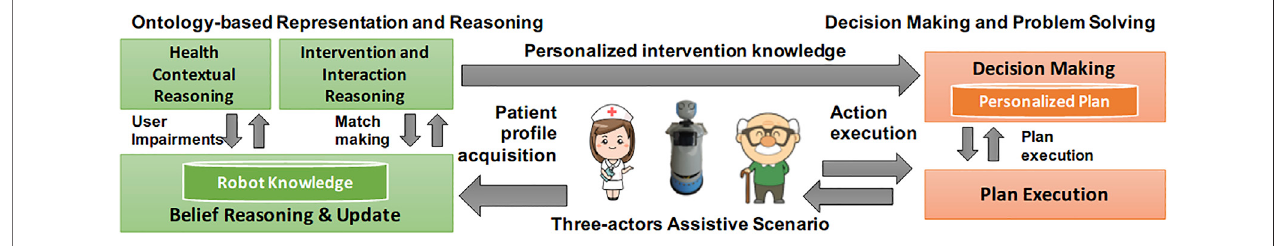
FIGURE 2 | Overview of the AI-based cognitive